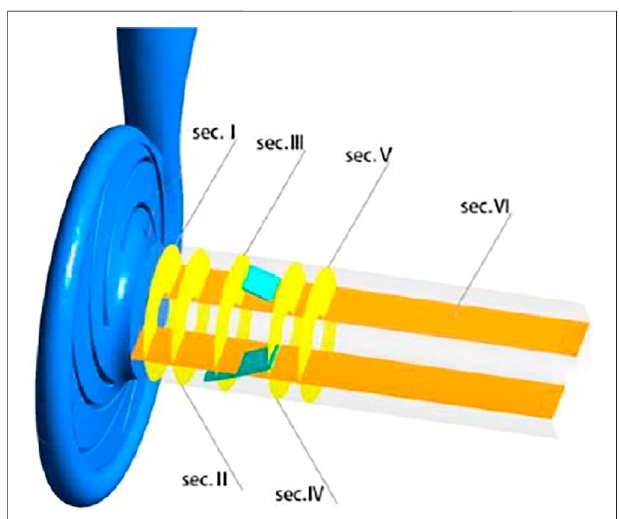
FIGURE 11 | Cross-sections of the inlet